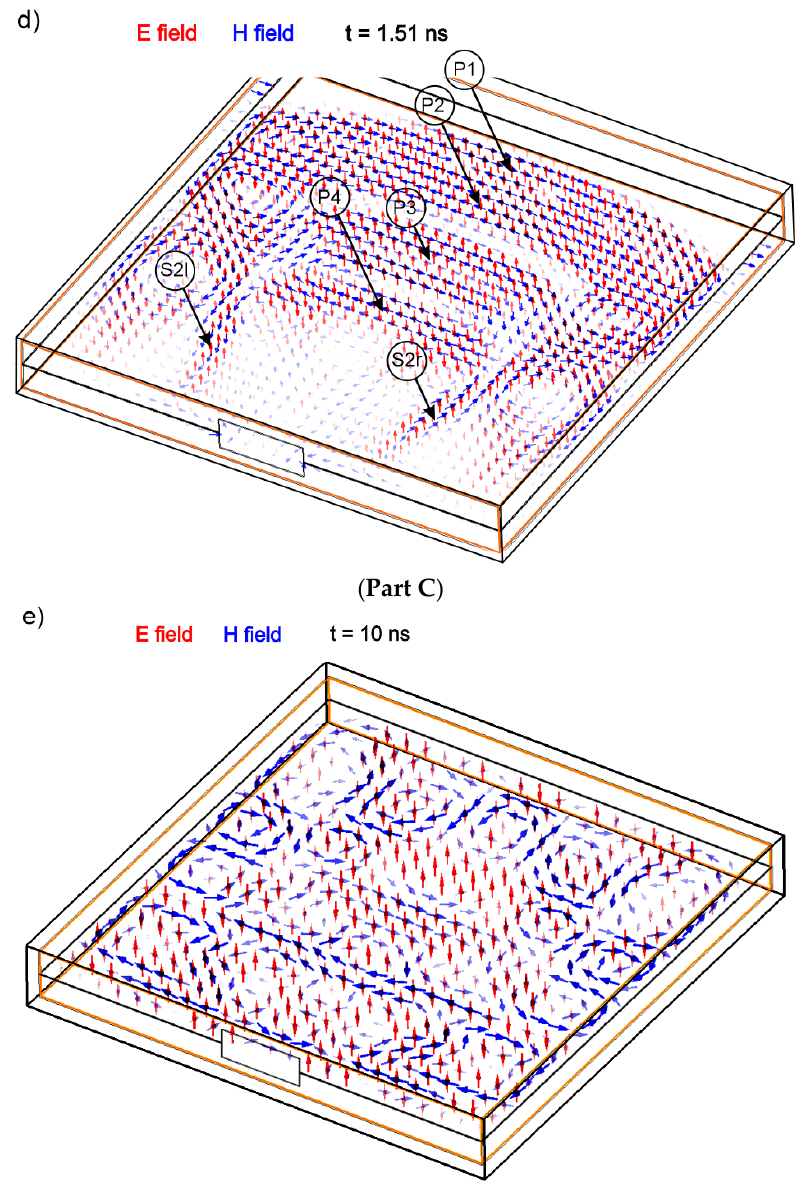
Figure 10. ( Part A ) Associated electric E and magnetic H fields for several selected cases showing: ( a ) the primary wave P1 detaching from the aperture ( t = 0.245 ns), ( b ) the primary waves P1 and P2 developed in the enclosure ( t = 0.58 ns). ( Part B ) Associated electric E and magnetic H fields for several selected cases showing: ( c ) the primary waves P1, P2, P3, and P4 present in the enclosure ( t = 0.985 ns, ( d ) the secondary waves S2l and S2r in the early interference stage ( t = 1.51 ns). ( Part C ) ( e ) Associated electric E and magnetic H fields showing the E and H field patterns in the developed interference stage ( t = 10 ns). Retrieved from Figure